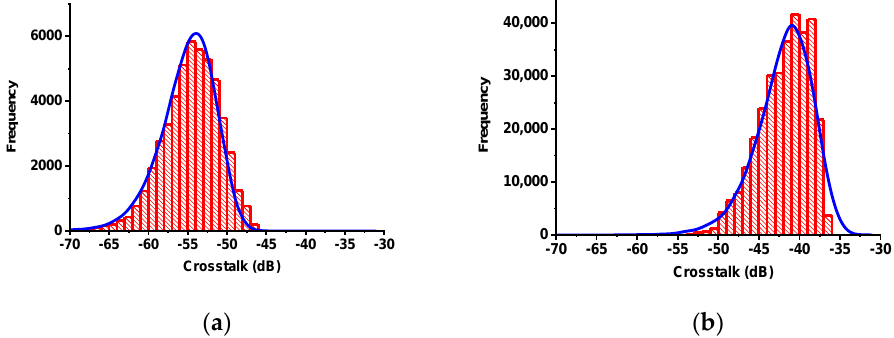
Figure 18. Crosstalk statistical distribution functions for 100 m fiber: ( a ) shipping reel; ( b ) straight fiber. Blue lines: modeled χ 2